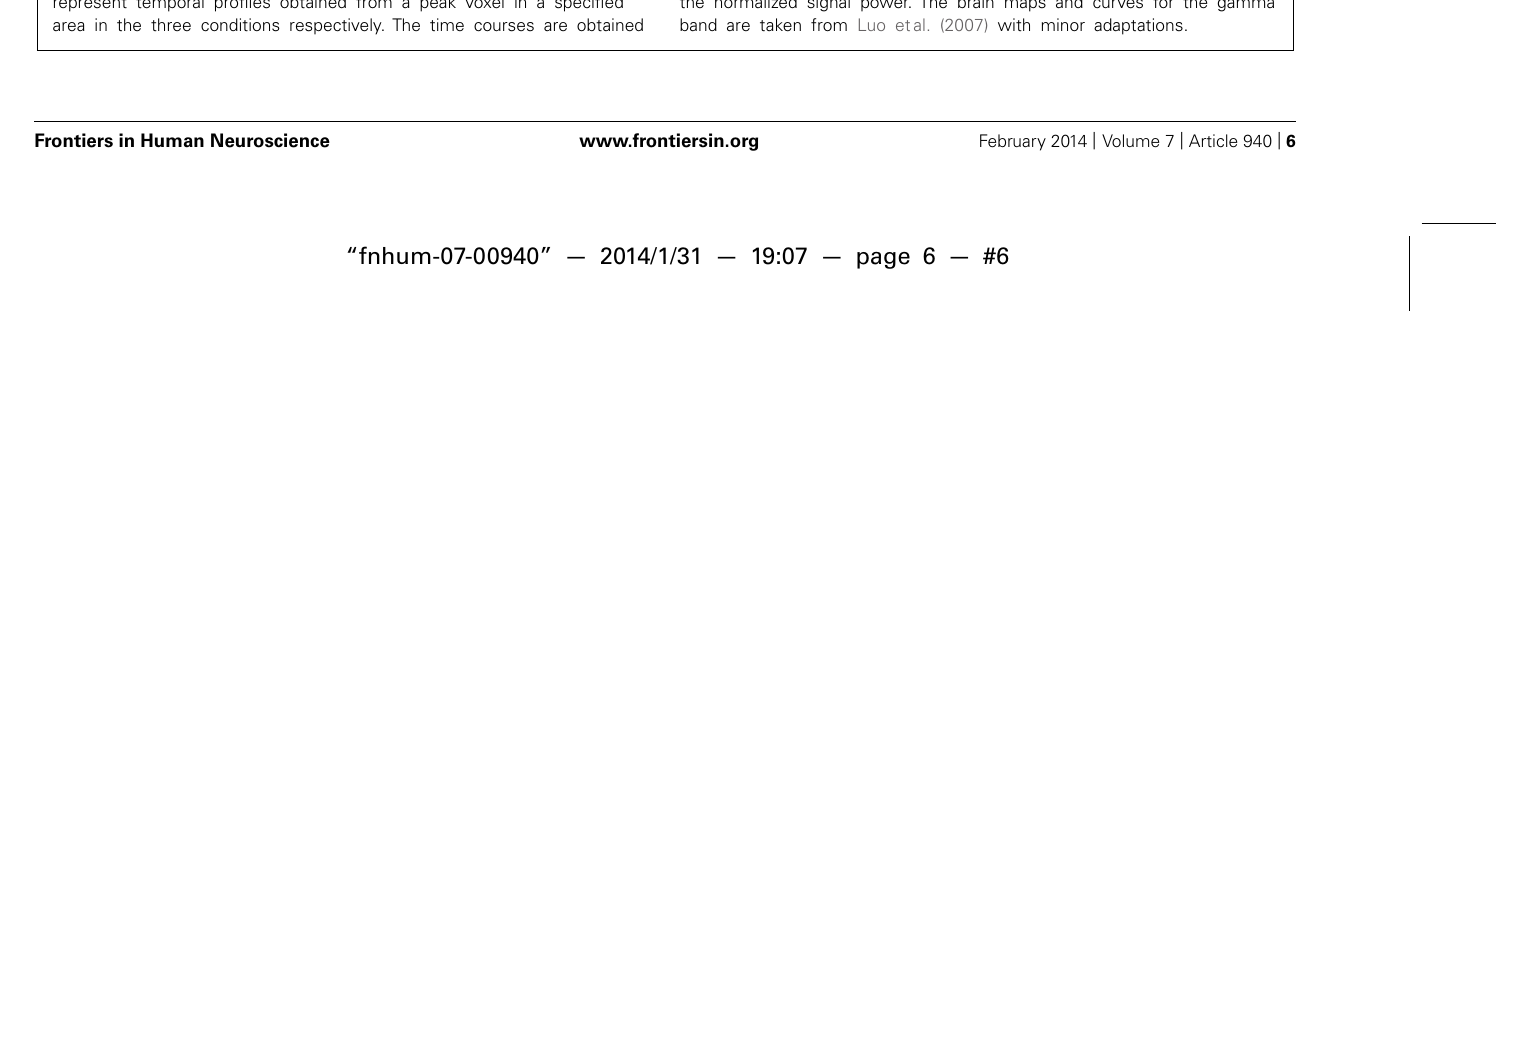
from the normalized power value in each window. The blue curve refers to responses to fearful, the purple to angry and the yellow to neutral expressions. The X-axis represents the development of time (ms) with an increment of 10 ms for each time segment. The Y-axis represents the normalized signal power. The brain maps and curves for the gamma band are taken from Luo etal. (2007) with minor